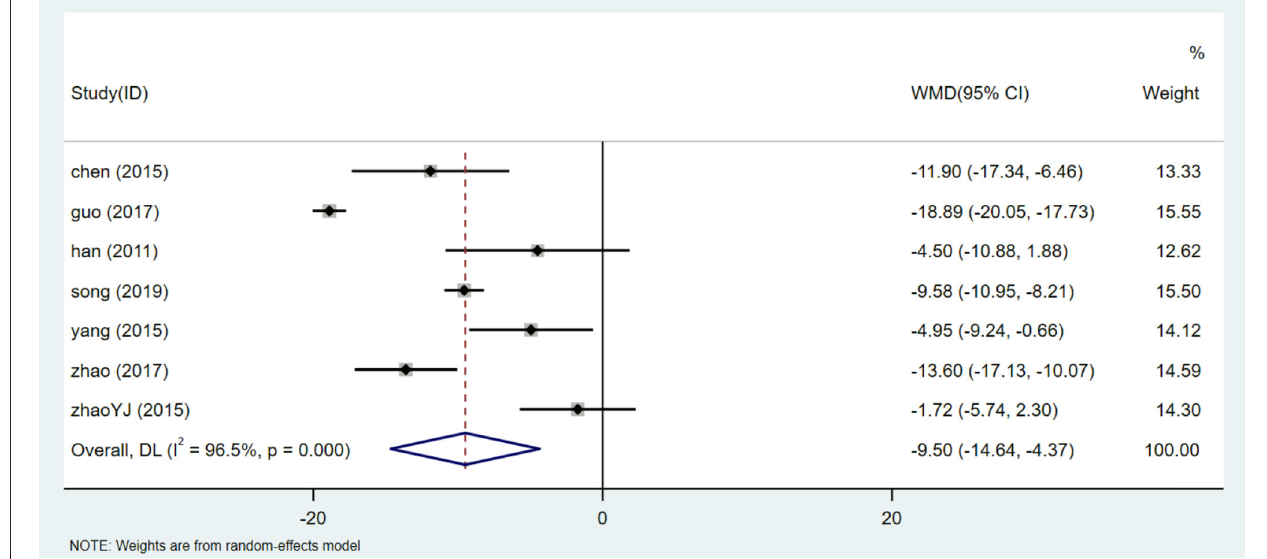
based on HQI usage dose showed that subgroup using more than 30 ml HQI [WMD = − 4.588, 95% CI ( − 6.036, − 3.140), P = 0.000, I 2 = 0.0%] and < 30 mL HQI [WMD = − 5.623,